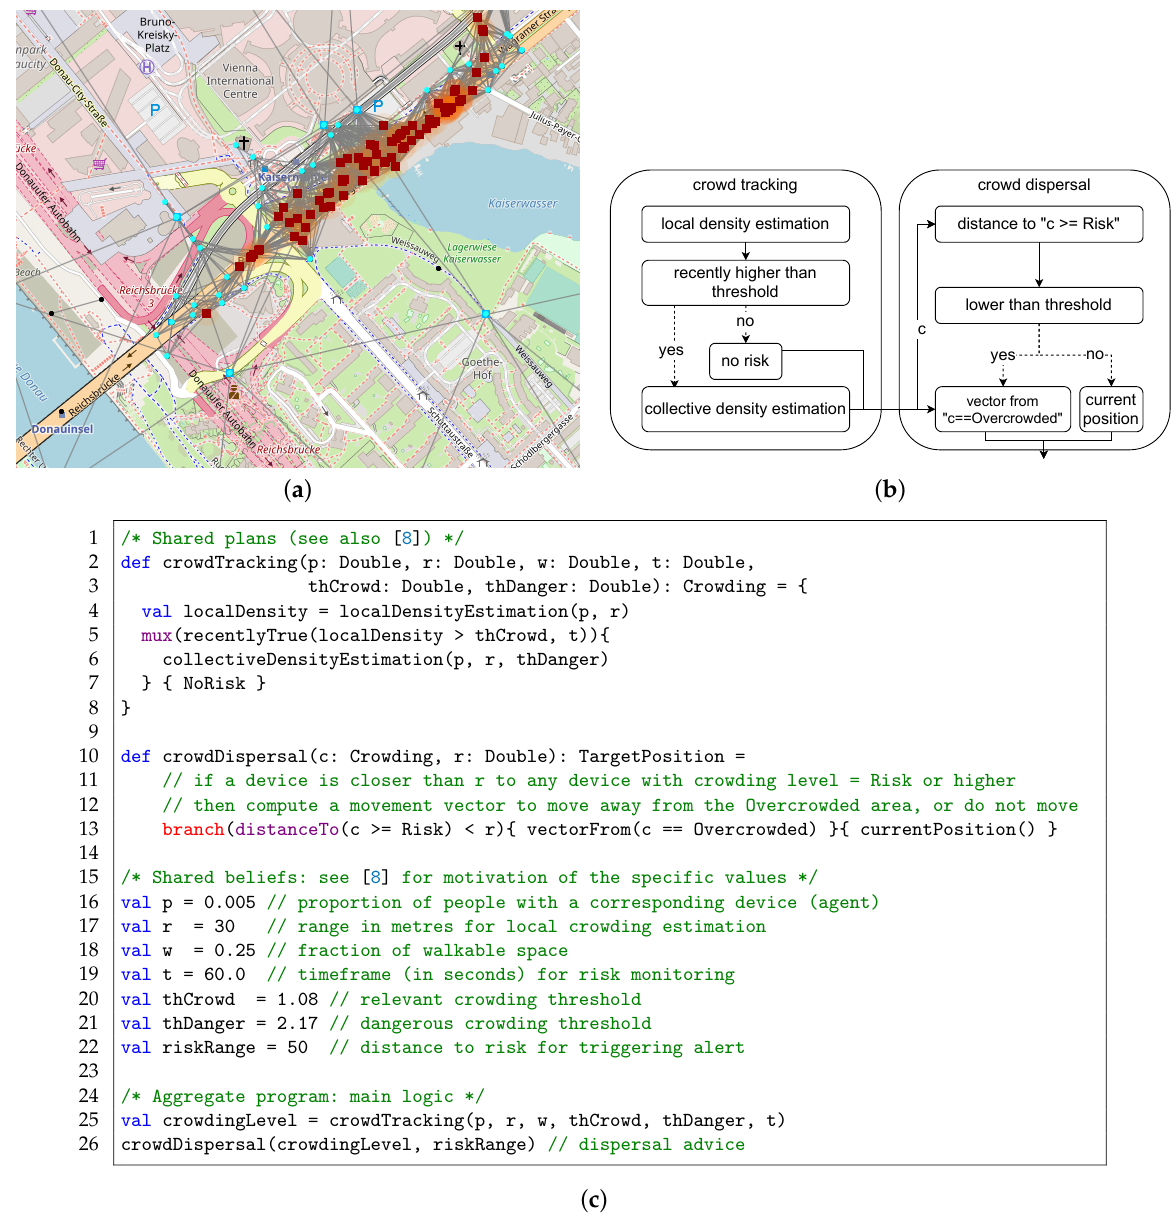
Figure 2. Crowd detection and steering example: snapshot, architecture and program. ( a ) A simulation snapshot of the crowd detection and steering example. Red nodes are devices in an overcrowded area; cyan nodes are nodes at risk since close to overcrowded devices; black nodes are in a safe location. Solid lines denote connectivity links (the longer links are those between infrastructural nodes); ( b ) diagram corresponding to the ScaFi application code below. Boxes denote computational field expressions; solid arrows denote input/output relationships; dashed arrows are a shorthand to denote conditional selection (when initially separated—for mux , where the “then” and “else” expressions are both evaluated, but only one is returned) and conditional evaluation (when initially joined—for branch , where only one between the “then” and “else” expression is evaluated and returned). ( c ) Aggregate program as implemented in